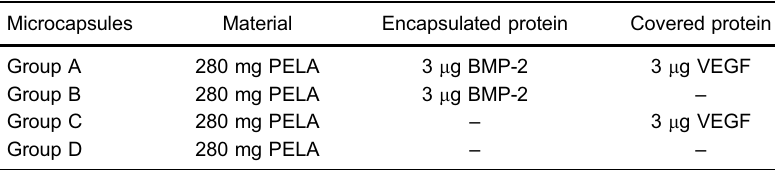
Table 1. Microcapsules containing BMP-2 for scaffolds